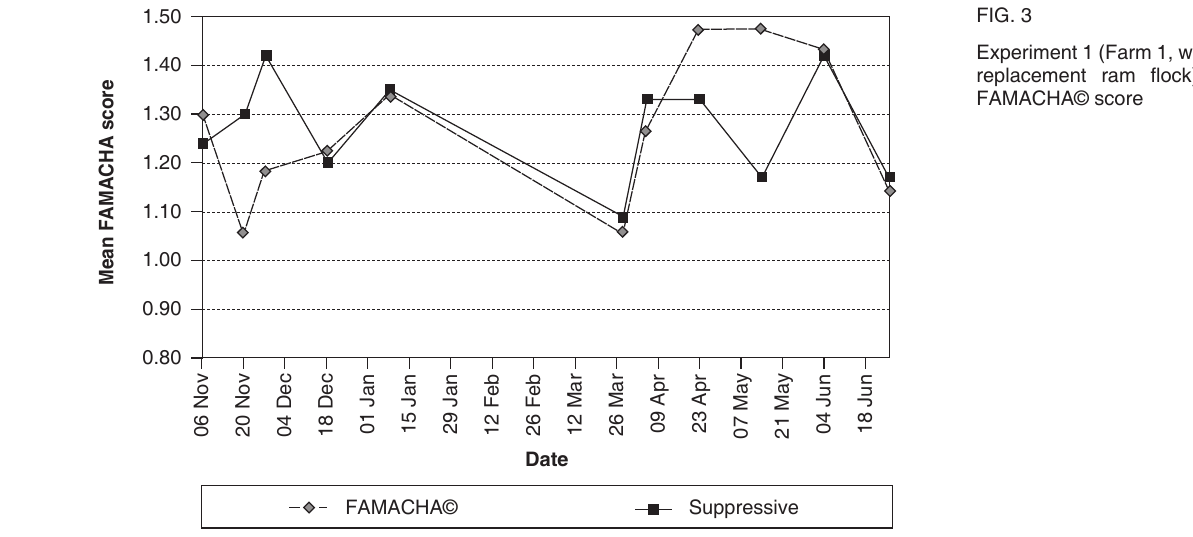
Experiment 1 (Farm 1, wethers in replacement ram flock):